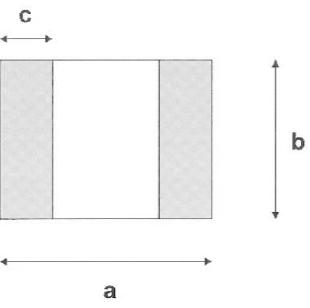
Figure 5. Schematic drawing of the sole of magnetizing yoke. a: total length of the yoke, b: width of the yoke, c: width of the leg. Table 2. Dimensions of the magnetizing yokes.